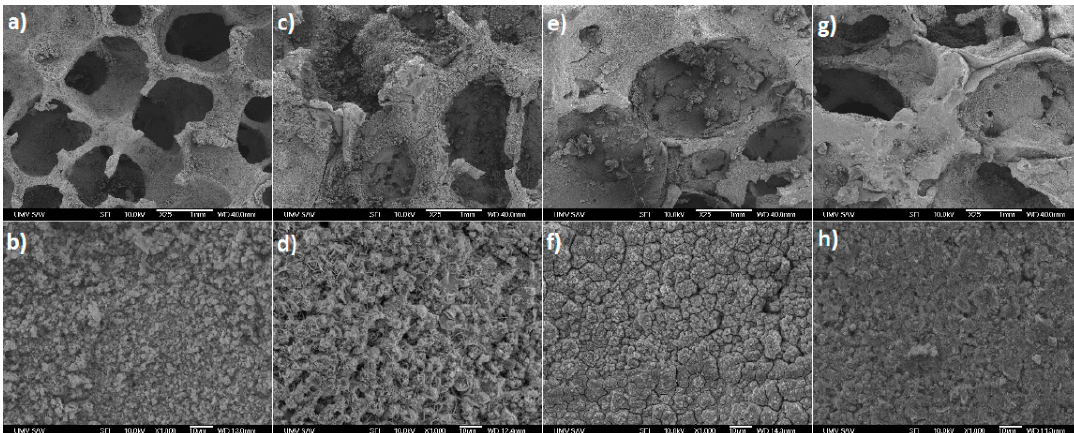
Figure 6. SEM micrographs of sintered iron samples after 4 weeks of corrosion in Hanks’ solution: Fe sample without any PEG ( a , b ); Fe-PEG1, 0.8 wt. % PEG ( c , d ); Fe-PEG2, 1.5 wt. % PEG ( e , f ); and Fe-PEG3, 3.0 wt. % PEG ( g , h ). Detail of the surfaces above at a higher magnification ( b , d , f , h ).